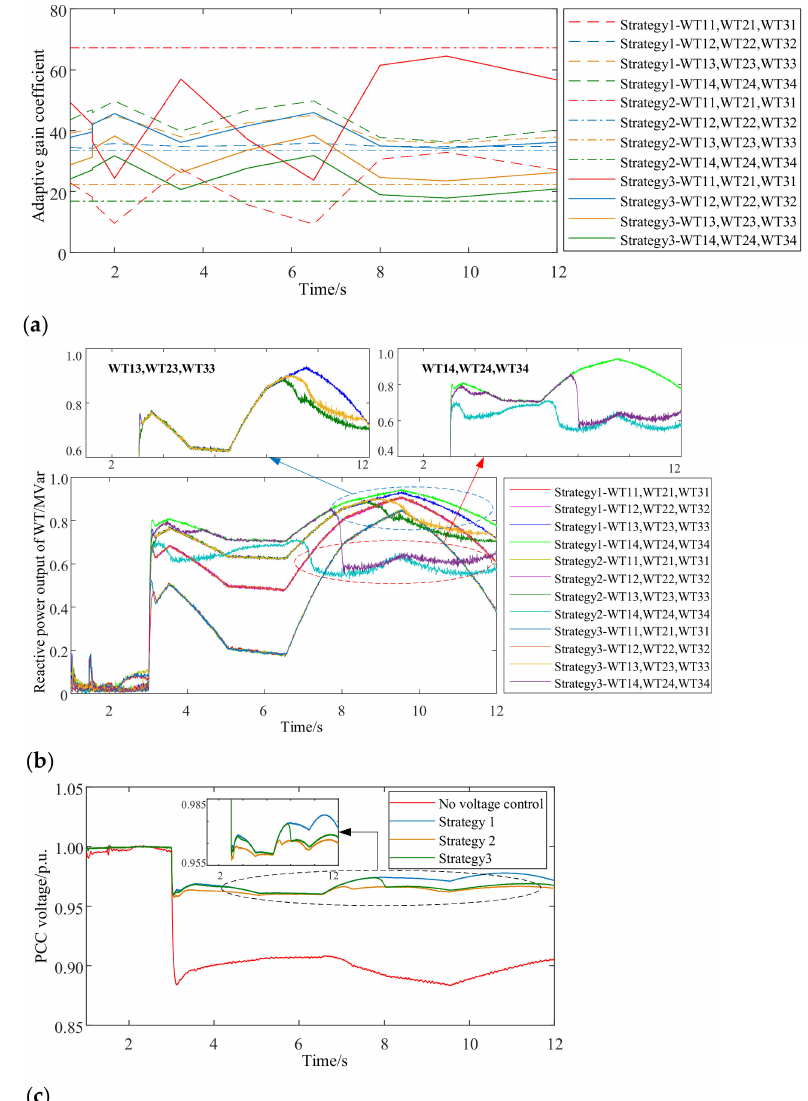
Figure 14. ( a ) The adaptive gain coefficient of each WT under the three different strategies; ( b ) The reactive power output of each WT under the three different strategies; ( c ) The PCC voltage under the three different strategies; The comparison diagram of the three different strategies in Scenario